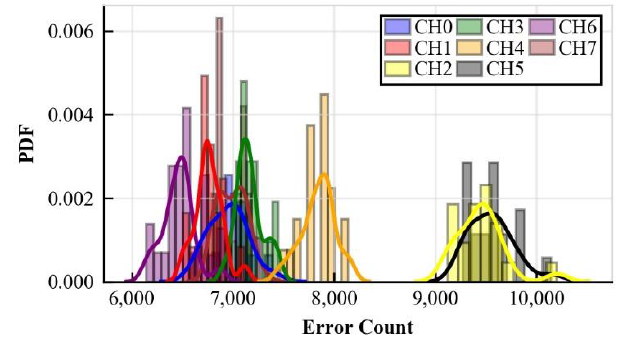
Figure 18. Histograms for error count in Pseudo channel 0 of all the channels at T L of 70 °C.